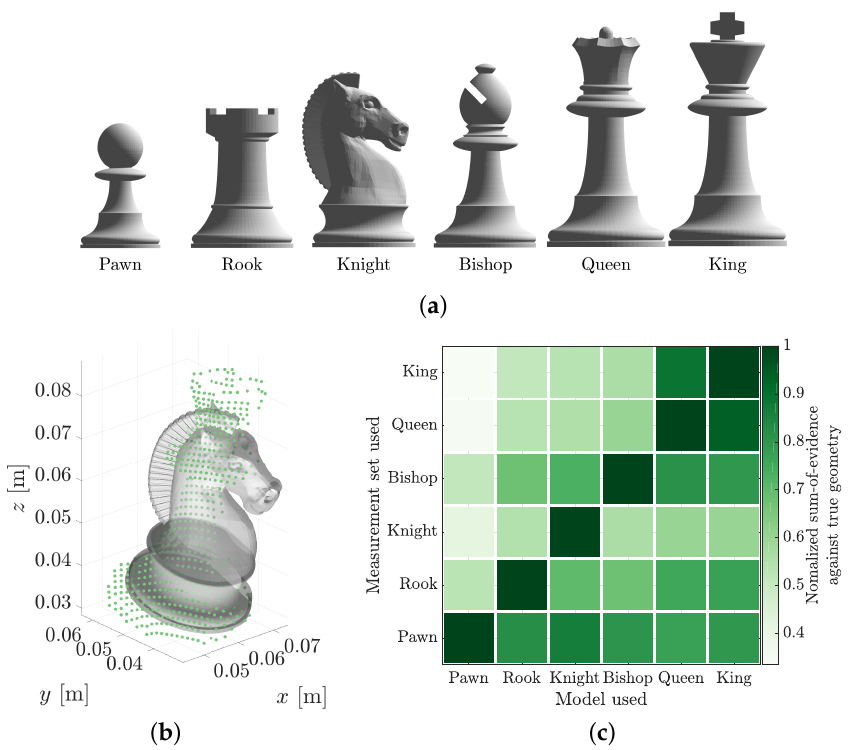
Figure 18. The maximum sum of evidence of a pose estimate can be used to identify which 3D geom- etry is most capable of reproducing the observed measurements. ( a ) Six chess piece geometry models. ( b ) The maximum sum of evidence pose ( H (cid:63) ) of the Knight geometry as estimated against point cloud measurements of the Queen . ( c ) The maximum sum of evidence obtained from each geometry model normalised against the maximum sum of evidence obtained using the true geometry